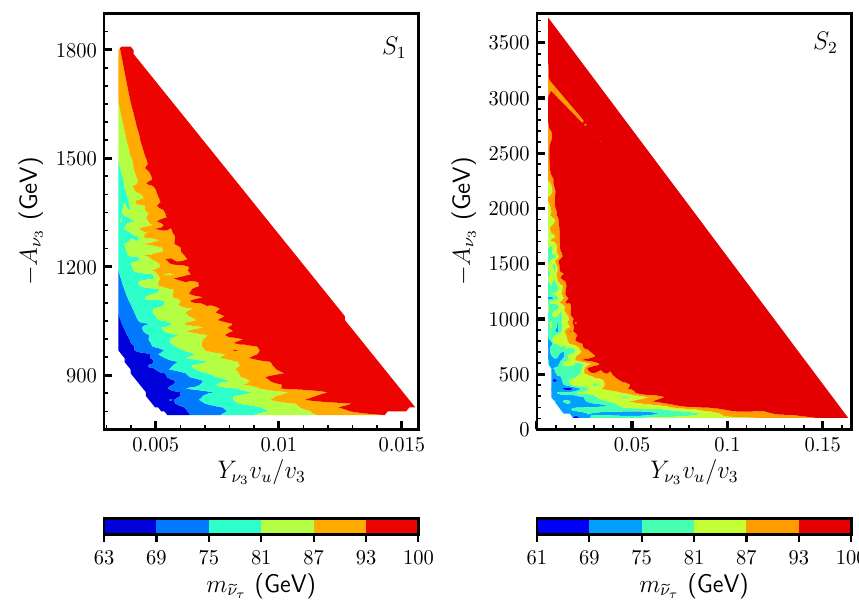
v /v versus Y ν u 3 3 3